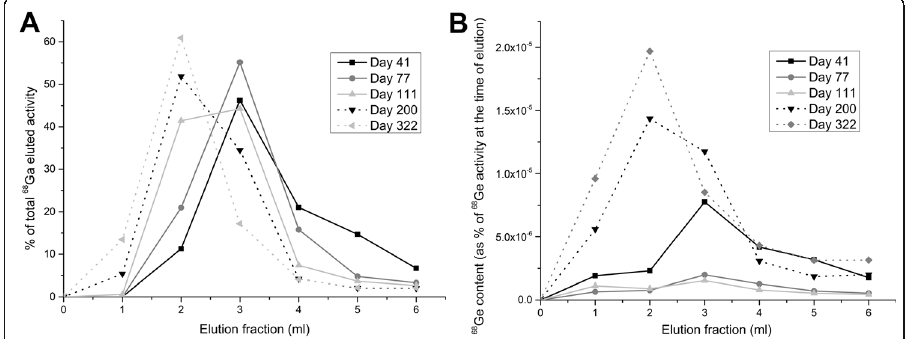
Fig. 3 Elution profiles on days 41, 77, 111, 200 and 322 post calibration for a : 68 Ga as percent of total eluted 68 Ga activity, and b : 68 Ge as percent of the initial 68 Ge activity present in the generator at the time of